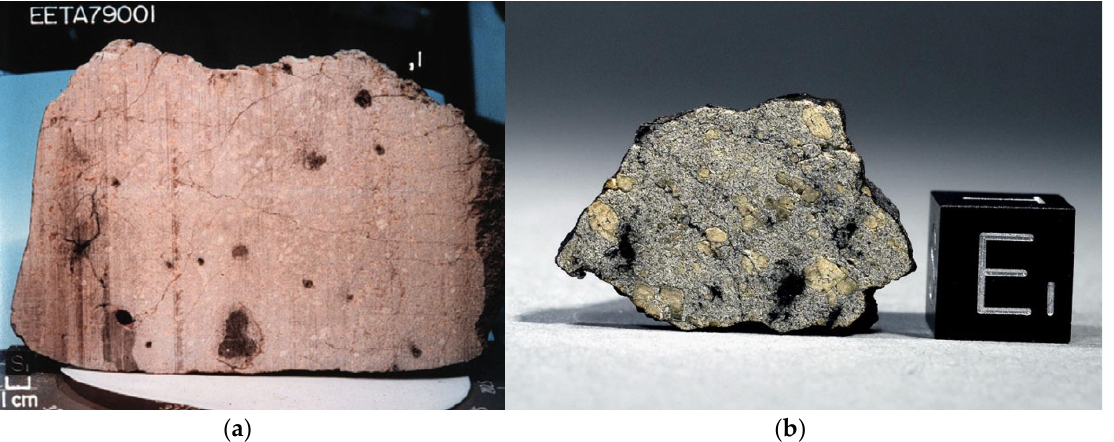
Figure 1. ( a ) The Martian meteorite Elephant Moraine (EETA) 79001 and the presence of black glass which contains trapped Martian atmosphere. Credit from NASA. ( b ) A fragment of Tissint meteorite with shock-produced glass pockets (black), photo credit Meteor-Center (scale is represented by the 1 1 inch scale cube).